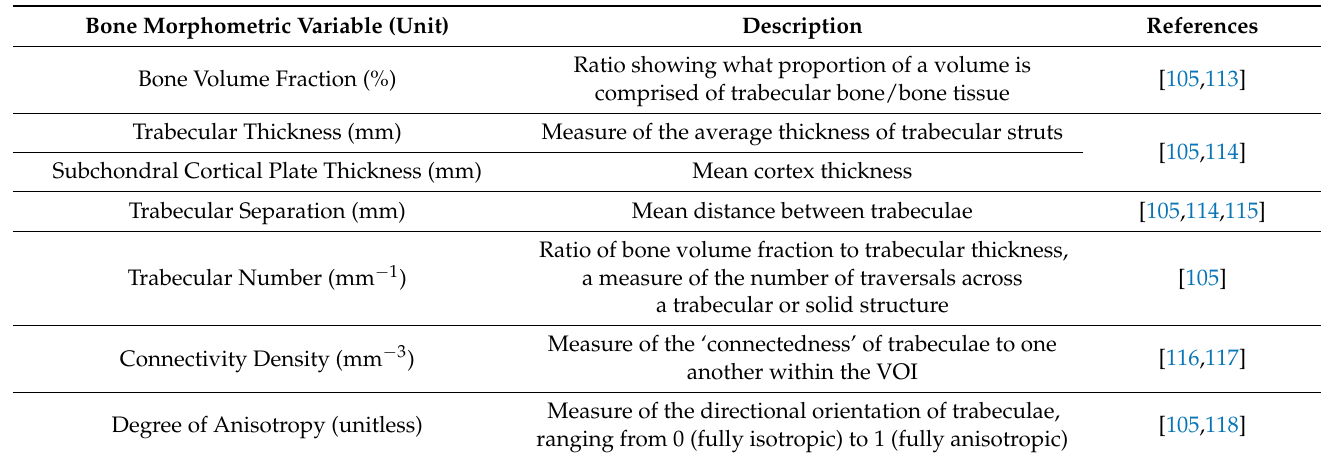
Table 2. Description of bone morphometric